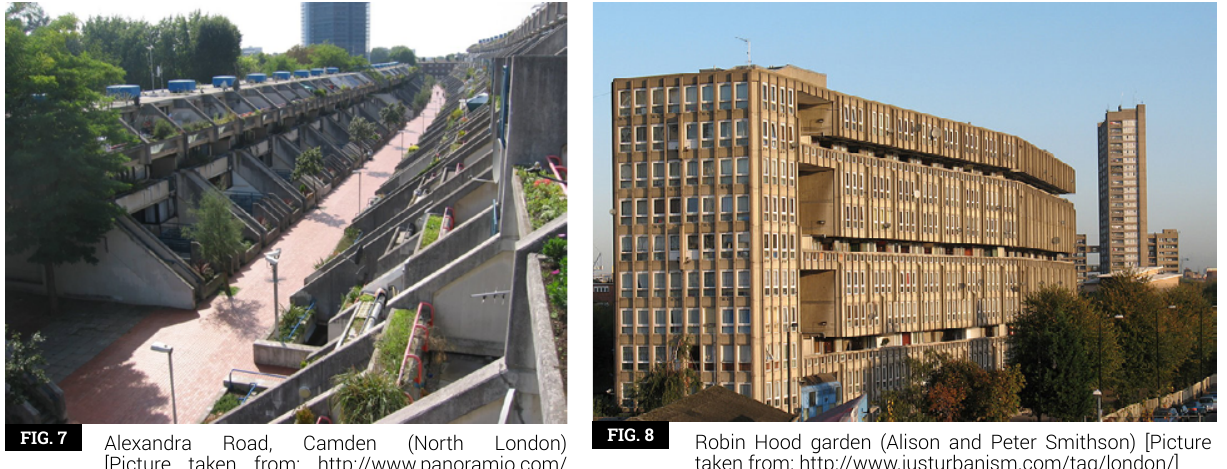
FIG. FIG. 7 Robin Hood garden (Alison and Peter Smithson) [Picture (North London) taken from: http://www.justurbanism.com/tag/london/] [Picture taken from: http://www.panoramio.com/